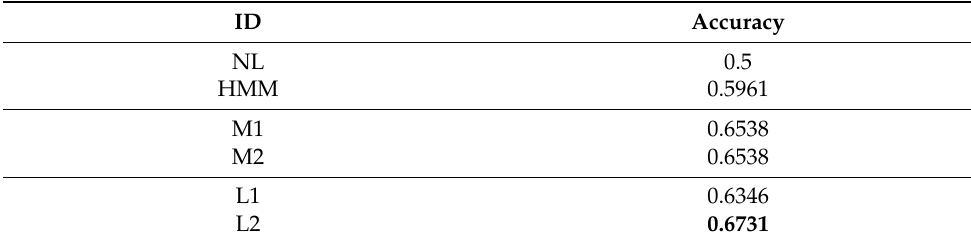
Table 4. Accuracy scores of the performed experiments. Nearest locations (NL), hidden Markov models (HMM), multi-scale CNNs (M1), multi-scale CNNs with attention (M2), LSTM (L1), LSTM with attention (L2).